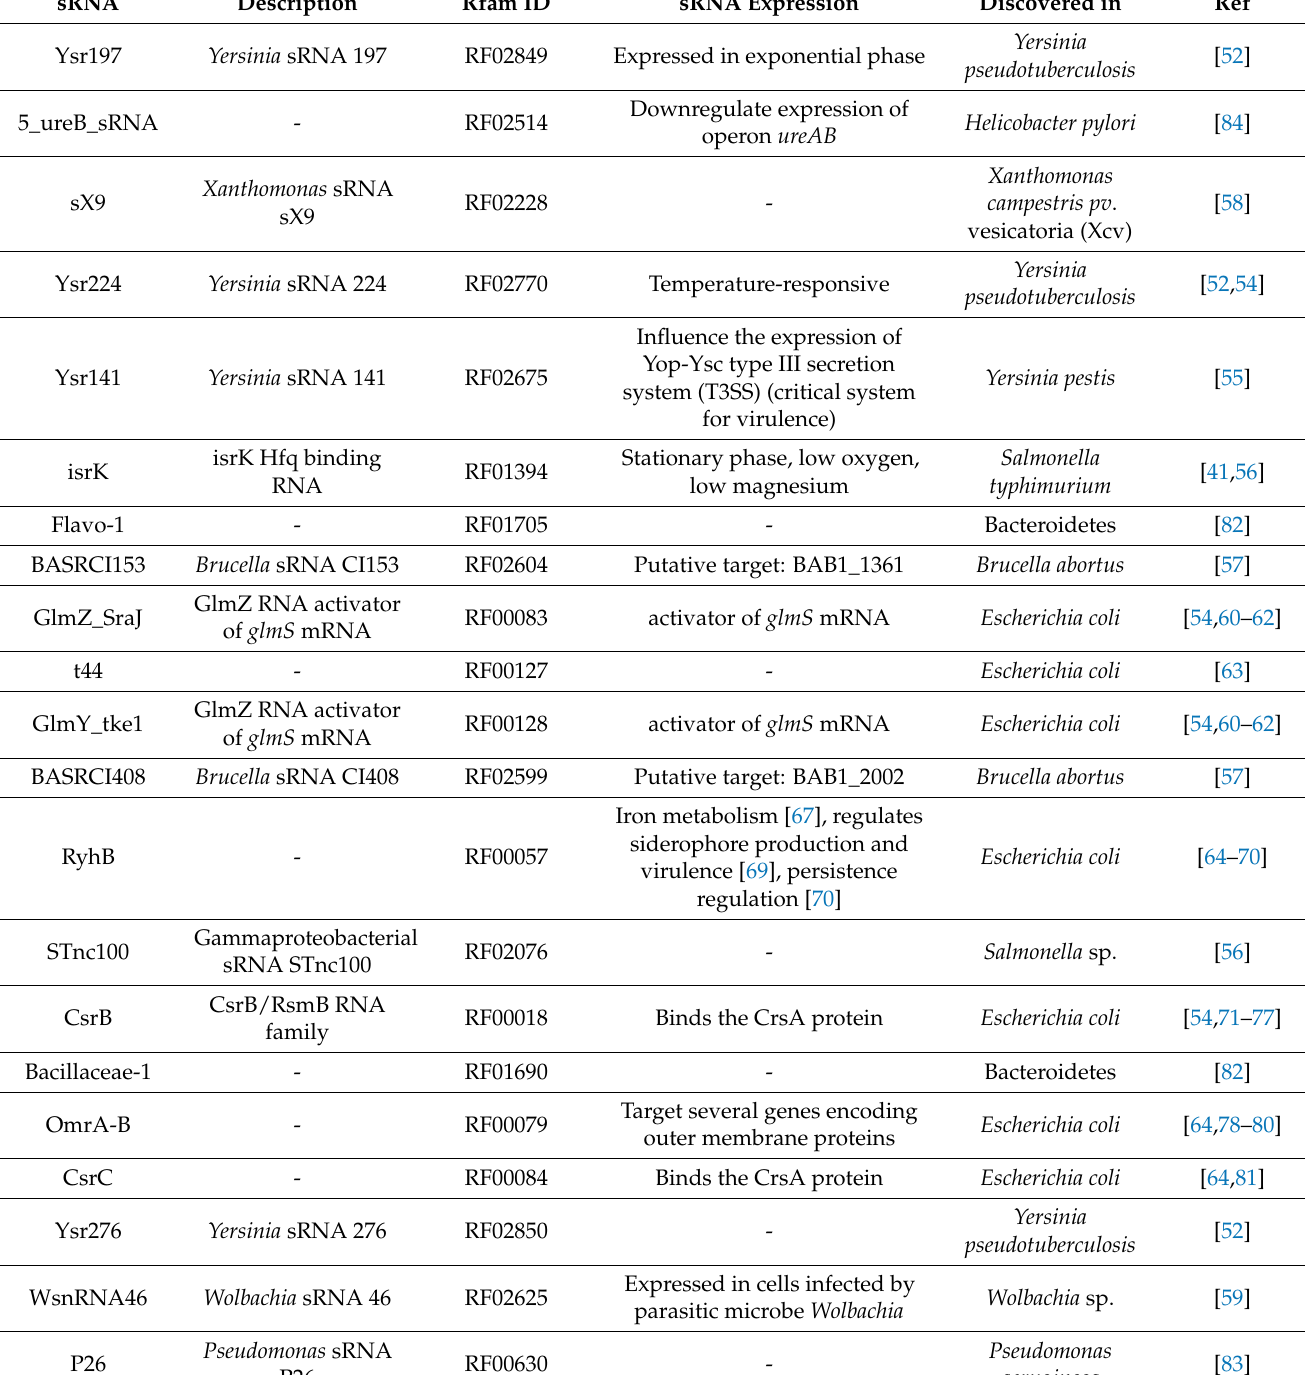
Table 3. Description of top 20 most prevalent sRNAs in